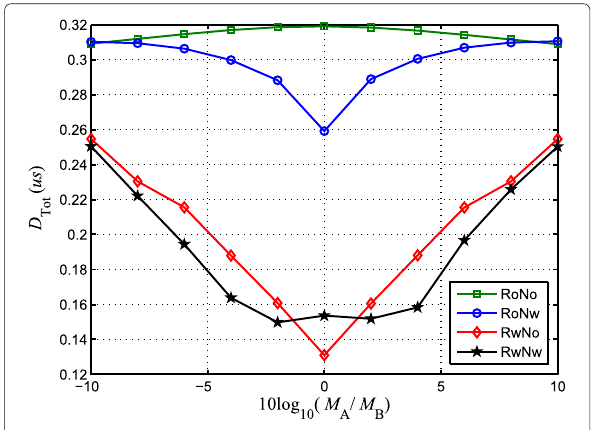
Fig. 12 D Tot performance comparison of the four schemes in Example 2, where h A = [1 2 2 3 4 5 5 6 6] and h B = [6 6 6 5 4 4 3 2 1 1]